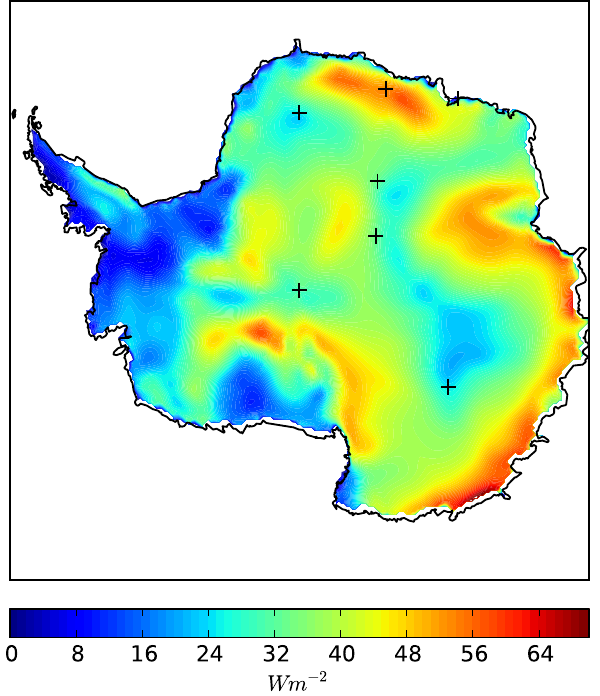
Figure 9. Averaged ERA-i sensible heat fluxes from the atmosphere towards the surface in August